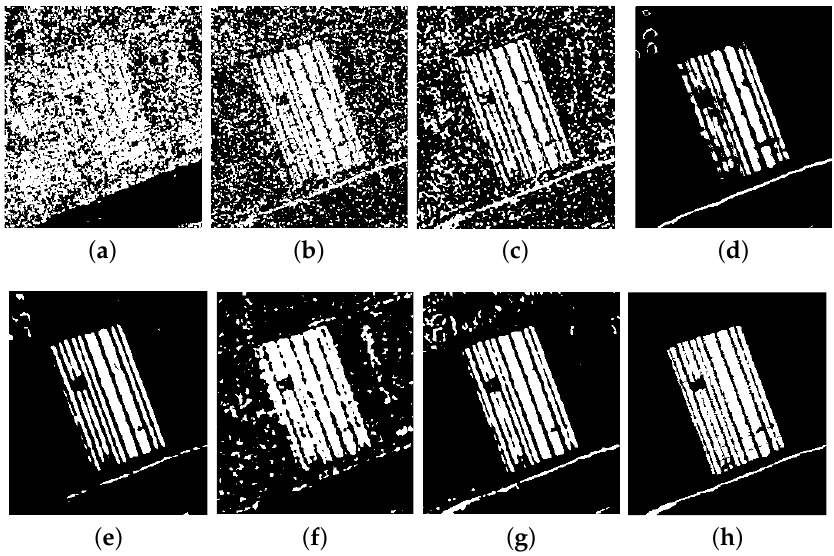
Figure 21. The ROC plots of the five difference maps on ( a ) the Yellow River data set and ( b ) the Campbell River data set.